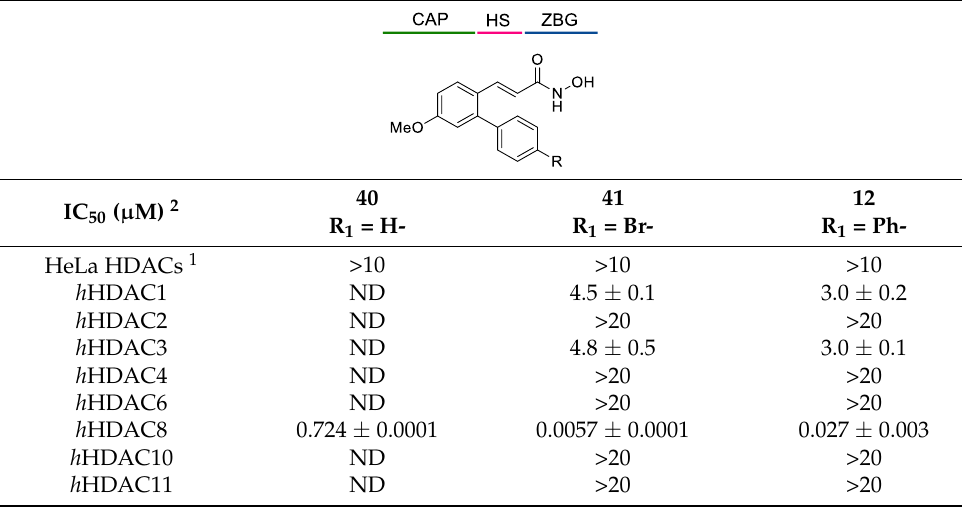
Table 8. General structure and IC 50 values of 40 , 41 , and 12 [148].